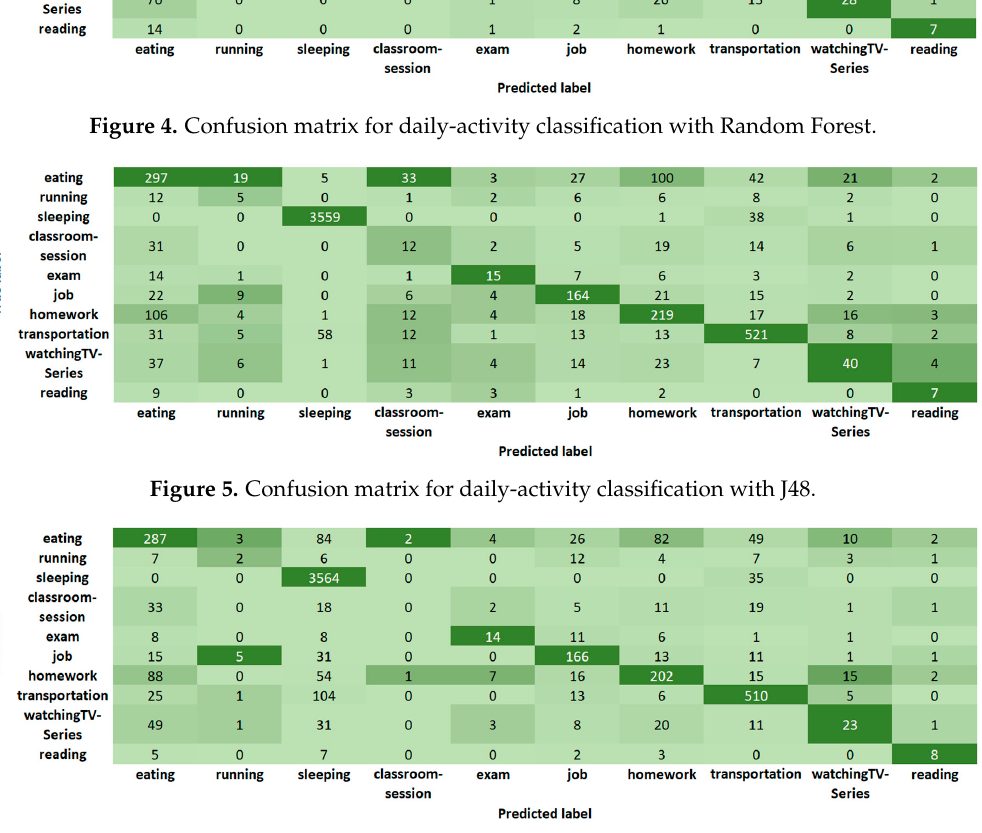
Figure 6. Confusion matrix for daily-activity classification with JRIP.